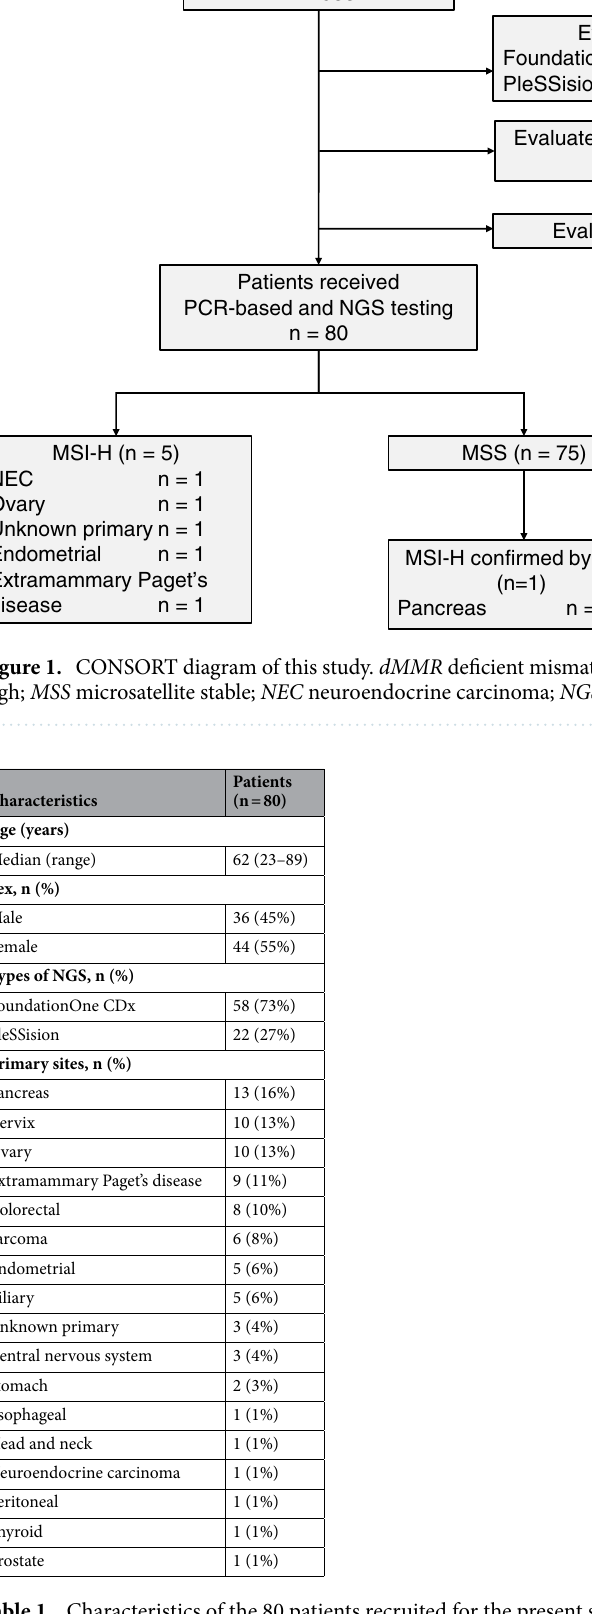
Table 1. Characteristics of the 80 patients recruited for the present study. NGS next-generation